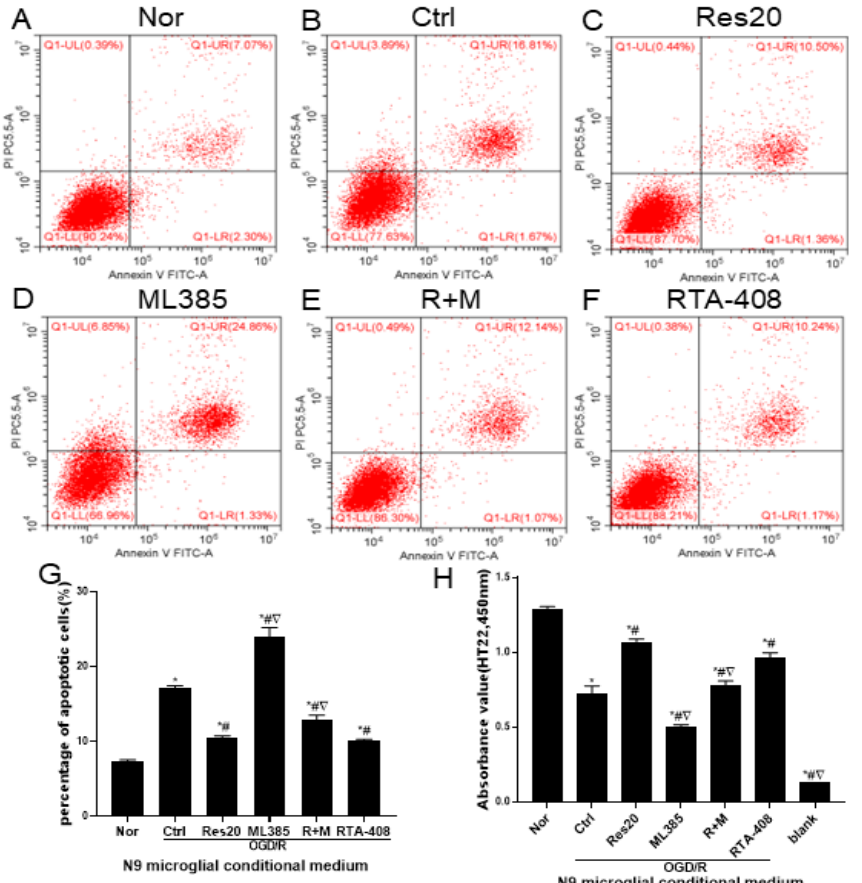
Figure 6. Nrf2 signaling mediated resveratrol to regulate neuronal apoptosis and viability in neuron-microglia co-culture. ( A – F ) Neuronal apoptosis detected by the Annexin V-FITC flow cytometer. ( G ) Percentage of apoptotic cells. ( H ) Neuronal viability detected by CCK-8 assay. * p < 0.05 vs. Nor; # p < 0.05 vs. Ctrl; ▽ p < 0.05 vs. Res20. Data are presented as the mean ± standard deviation and were compared using a one-way analysis of variance ( n = 3 for each group). Nor, normal; Ctrl, control; Res20, 20 μM resveratrol, ML385, Nrf2 inhibitor; R + M, 20 μM resveratrol combination with ML385; RTA-408, Nrf2 agonist.